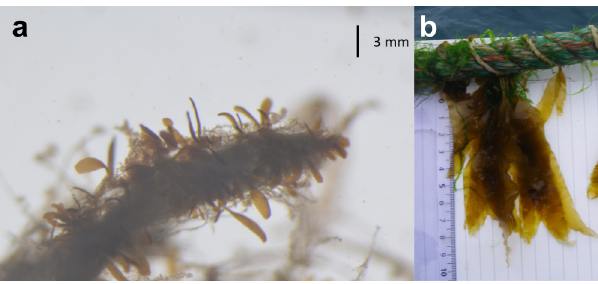
Fig. 3. (A) 20-day-old Saccharina latissima sporophytes on a Kuralon string. (B) 90-day-old S. latissima sporophytes on a long line.